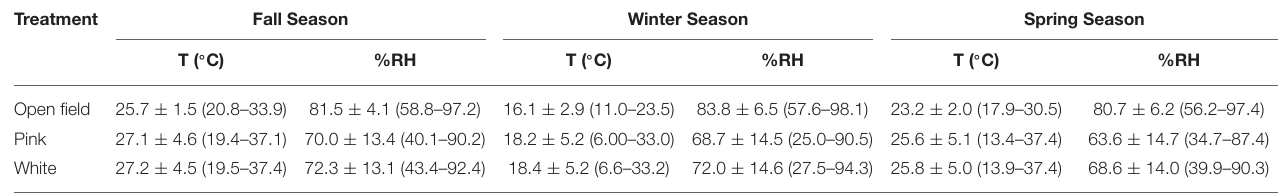
TABLE 11 | Climatic conditions [temperature ( ◦ C), (Mean ± SD; Min-Max range), and relative humidity (%RH), (Mean ± SD; Min-Max range)] during fall season (Sept 23–Oct 28, 2020), winter season (Dec 9 2020–Feb 8 2021), and spring season (March 24–May 5, 2021).